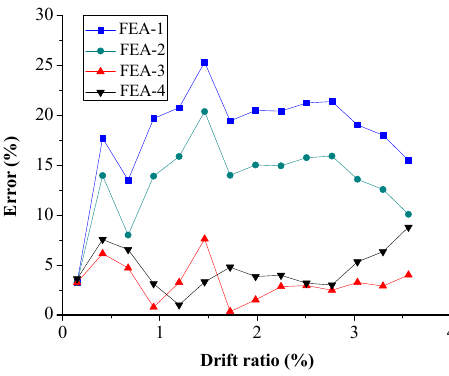
Figure 12. Root-mean-square error of lateral load.